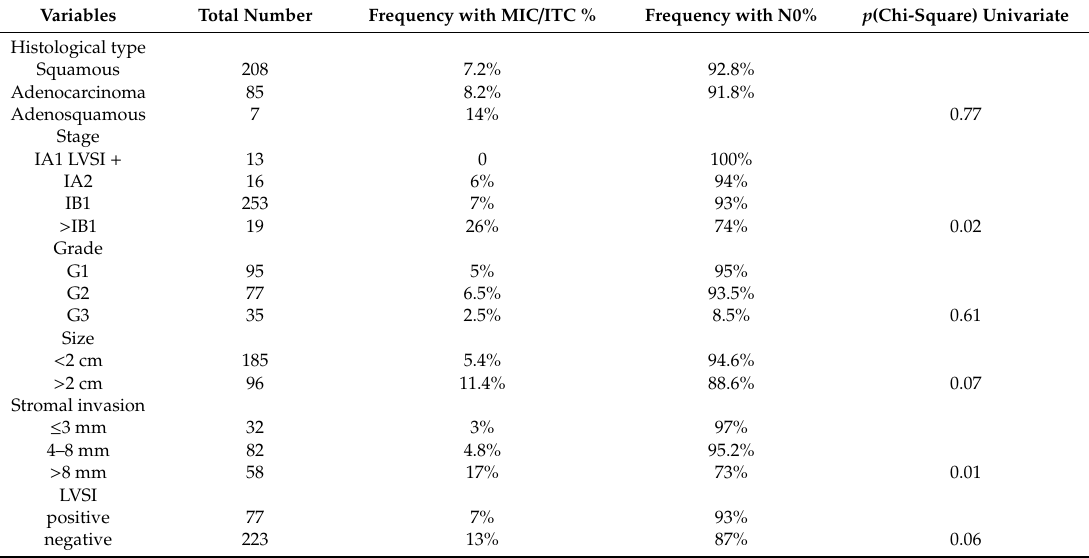
Table 2. The factors associated with the presence of low-volume metastasis versus N0.